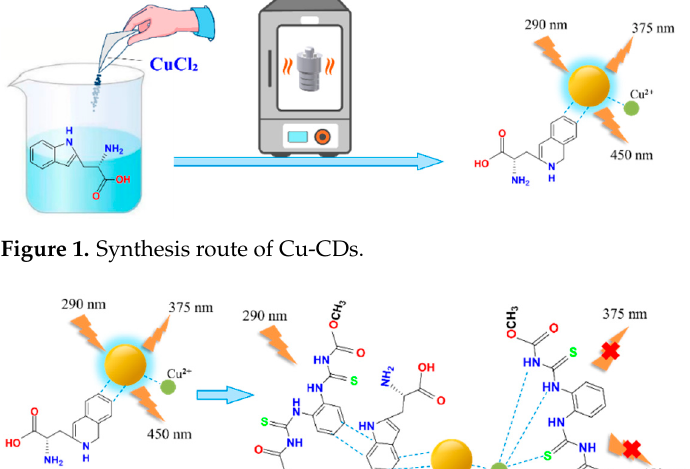
Figure 1. Synthesis route of Cu-CDs.